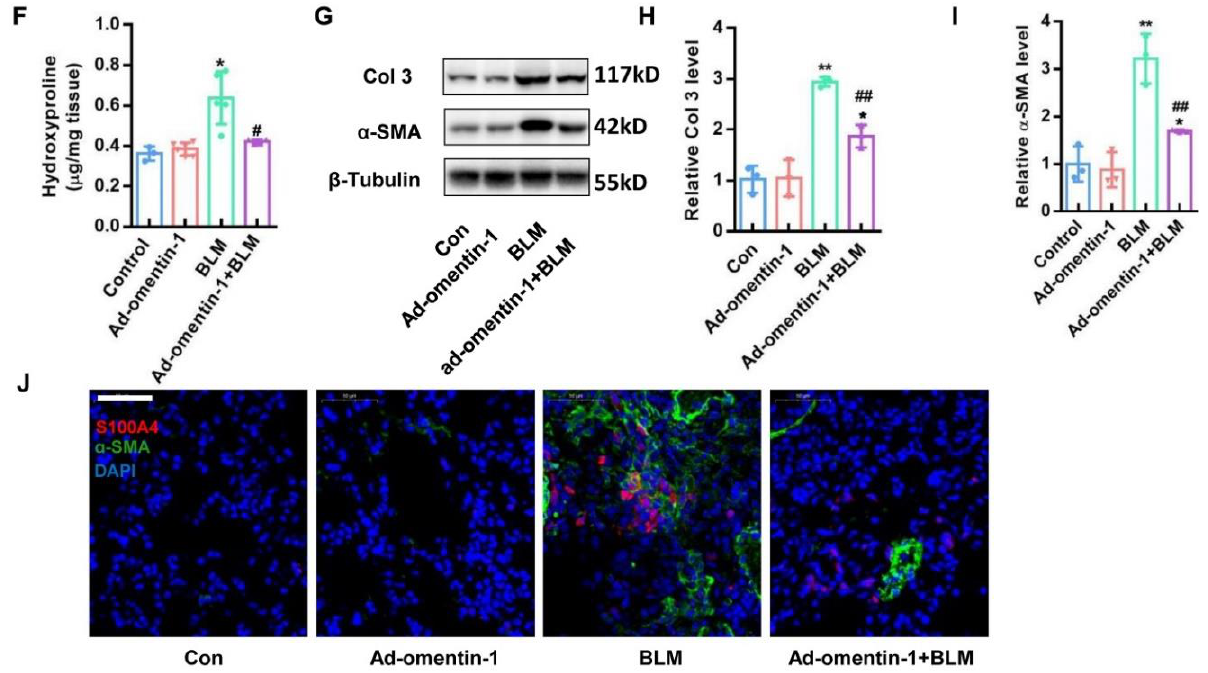
Figure 4. The effect of omentin-1 on BLM-injured mice by therapeutic treatment. ( A ) Experimental design: The therapeutic treatment with ad-omentin-1 was performed on D11 and D18 after BLM (fibrosis established). BLM (1.25 mg/kg) was injected to induce fibrosis in wild-type mice; ( B ) Body weight change of mice after BLM challenge ( n = 10); ( C ) Representative micrographs of H&E staining of lung tissue (Bar = 50 µ m, n = 5). ( D ) Representative micrographs of Masson trichrome staining, immunohistochemical staining of lung sections for Col3 and α -SMA (Bar = 50 µ m, n = 5); ( E ) Ashcroft score to grade fibrosis scale ( n = 5). ( F ) Collagen content was measured by hydroxyproline (HYP) assay ( n = 5). ( G )The content of Col3 and α -SMA in lung tissue detected by Western blotting with cropping gel at the relative molecular size ( n = 3); ( H ) Semi-quantitative analysis of Col3 level evaluated by Western blotting; ( I ) Semi-quantitative analysis of α -SMA level evaluated by western blotting; ( J ) The expression and localization of α -SMA and S100A4 in lung tissue detected by immunofluorescence (bar = 50 µ m, n = 5). The data are presented as the mean ± SD. * p < 0.05, ** p < 0.01 vs. control group. # p < 0.05, ## p < 0.01 vs. BLM